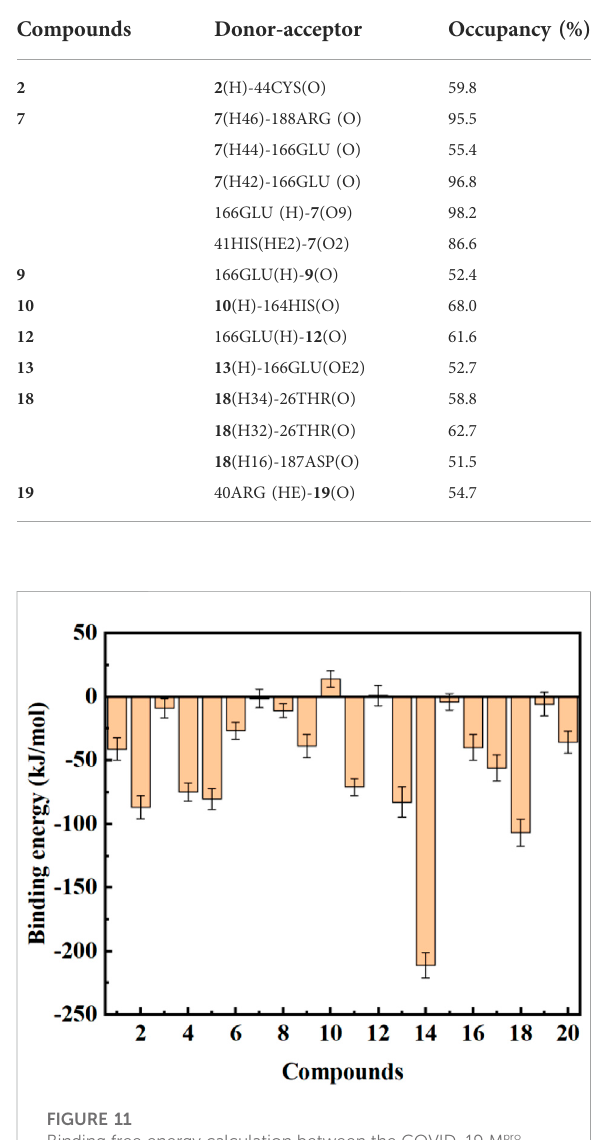
TABLE 3 Hydrogen bond occupancy of amino acid residues participating in H-bonding with the top 20 compounds, during entire MD simulation (only show more than 50% of results).